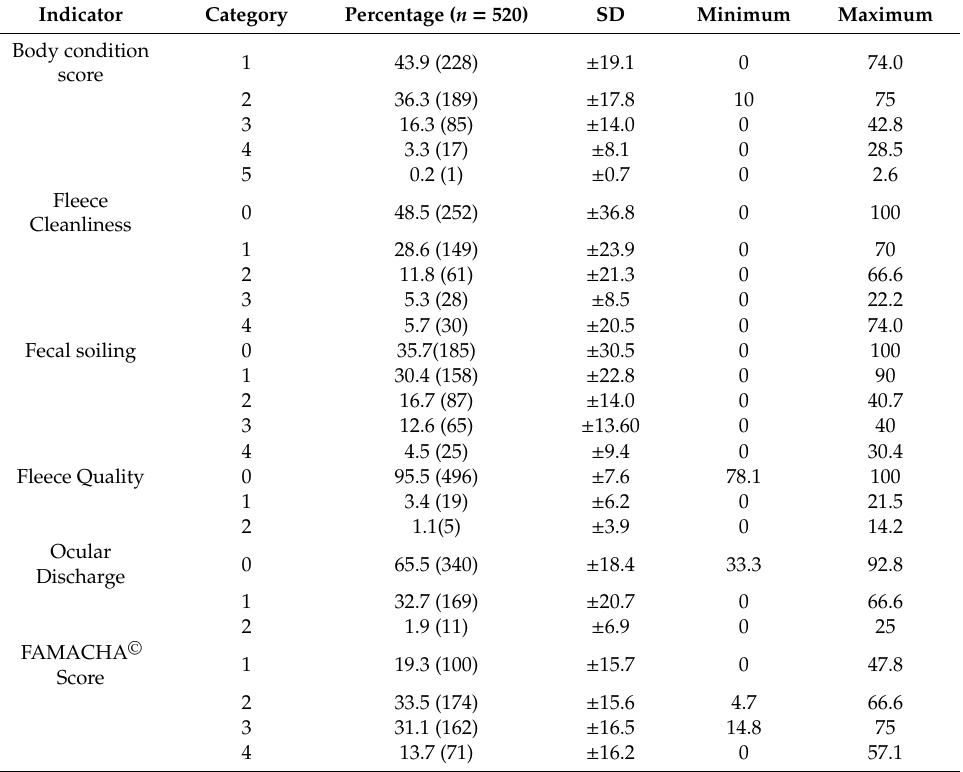
Table 3. Percentage, standard deviation (SD), minimum and maximum number scored for each category of animal-based welfare indicators.